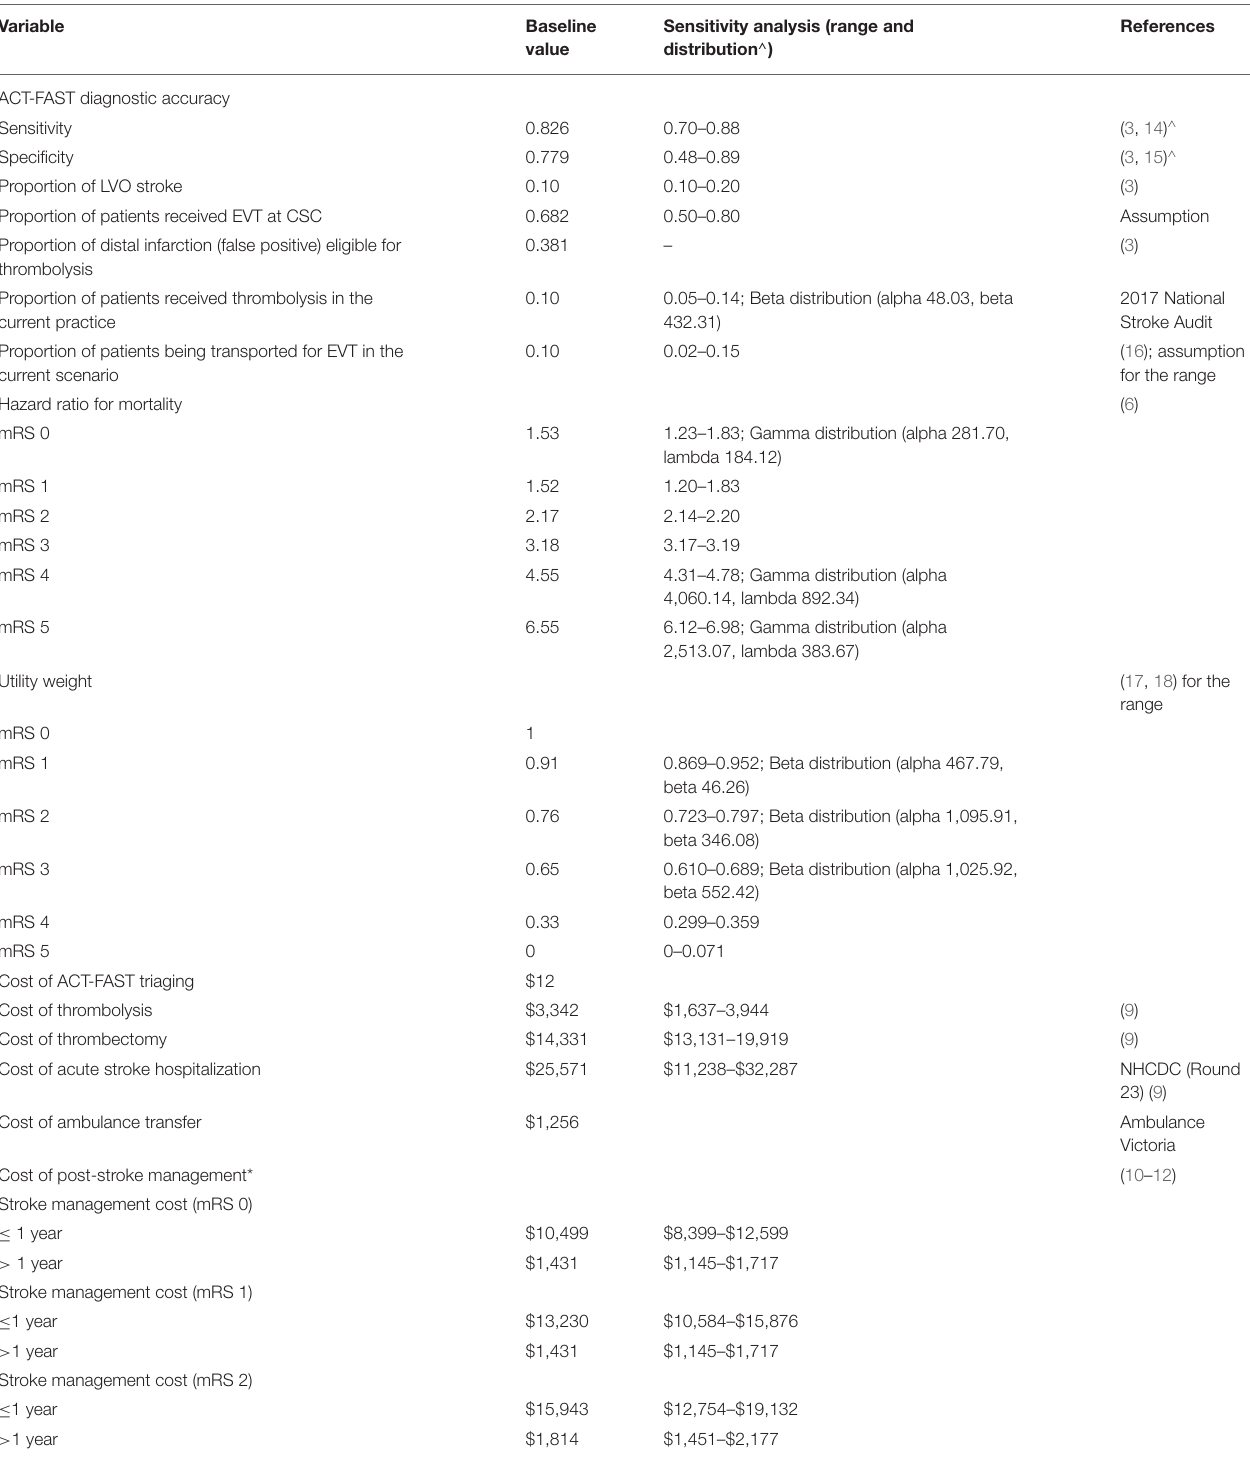
TABLE 1 | Inputs for the simulation